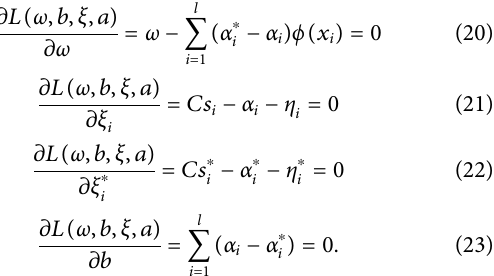
TABLE 5| PerformanceofCFSVR,CSVR, FSVR,SVR ofelectricloadforecasting. MAE SVR FSVR CSVR ( n (cid:1) 2) CFSVR ( n (cid:1) 2) CFSVR ( n (cid:1)